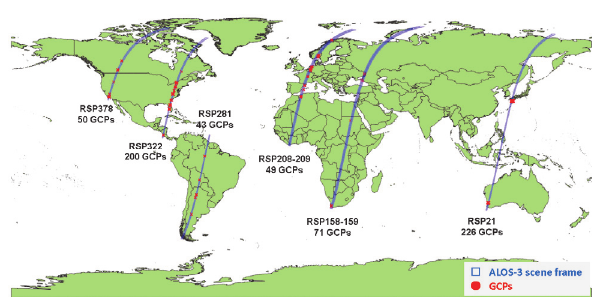
Figure 4. Preparation status of GCPs sites in the world